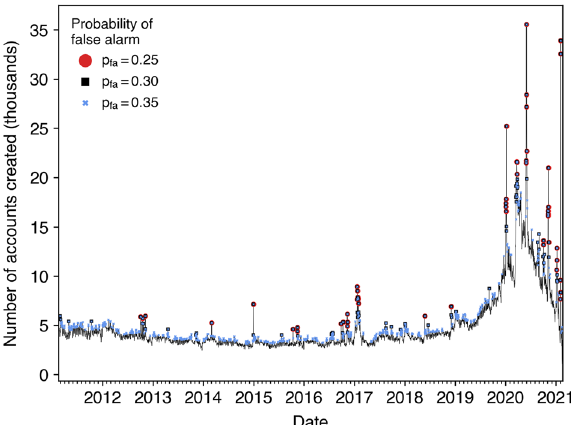
Fig. 2 The number of Twitter users created each day that appeared in our collection of election tweets. Bursts detected using different CFAR sensitivities are also indicated using different symbols